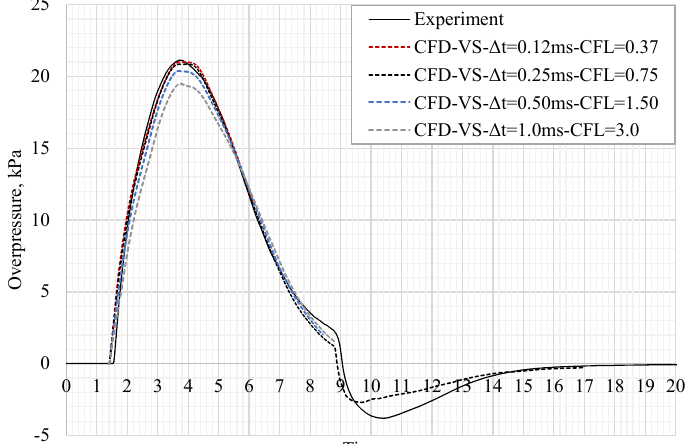
Figure 5. Simulated pressure dynamics in the enclosure and convergence by CFL number with the volumetric source model versus experimental pressure transient for Test No.14 ( P S = 11.78 MPa, . m = 11.37 g/s, Number of experimental vents = 3).